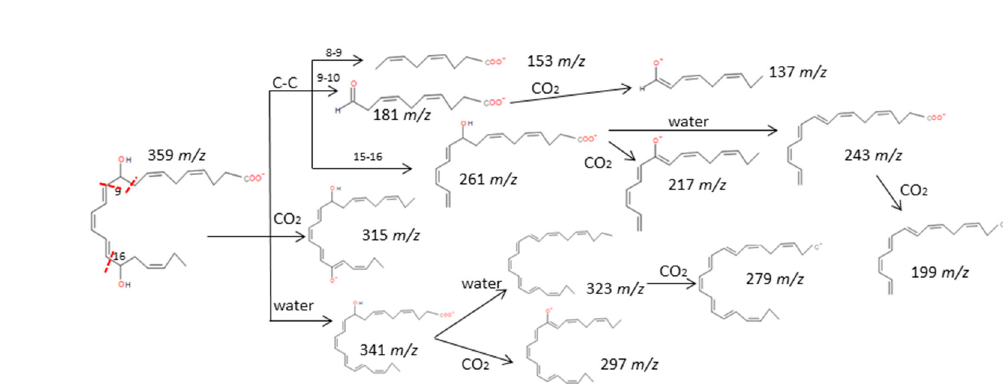
Figure 5. Fragmentation patterns suggested for ( a,b ) RvD 1 , ( c ) RvE 1. and ( d,e ) PD 1 . Product ion